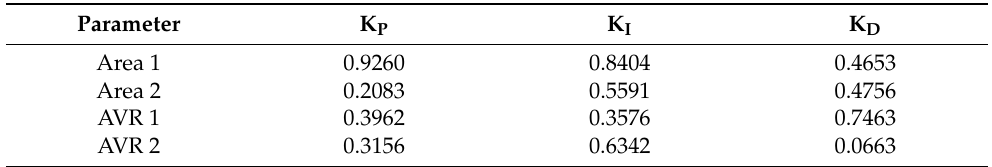
Table 19. PID parameters for the combined AGC and AVR system with RLD, all non-linearities, and a 0.2 s